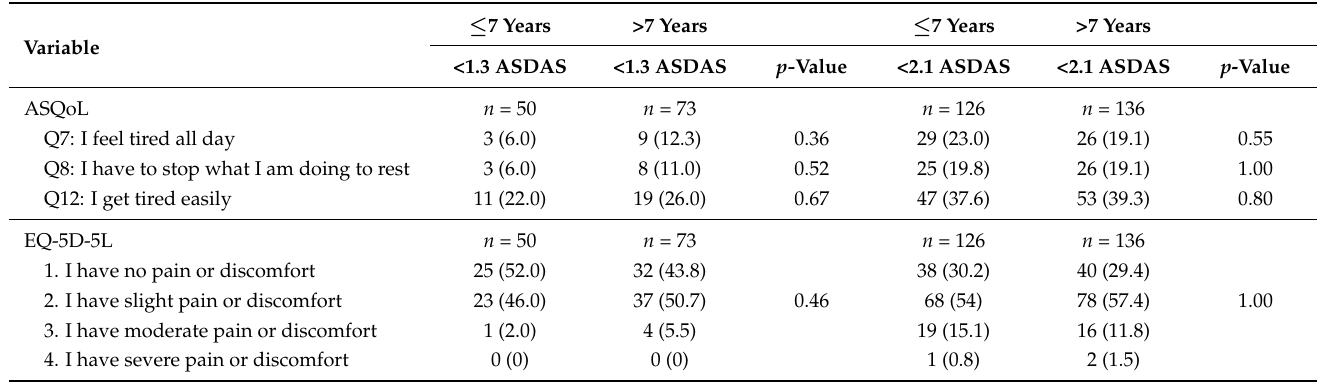
Table 7. Quality of life in patients with axial spondyloarthritis using ASQoL and EQ-5D-5L stratified by disease duration and